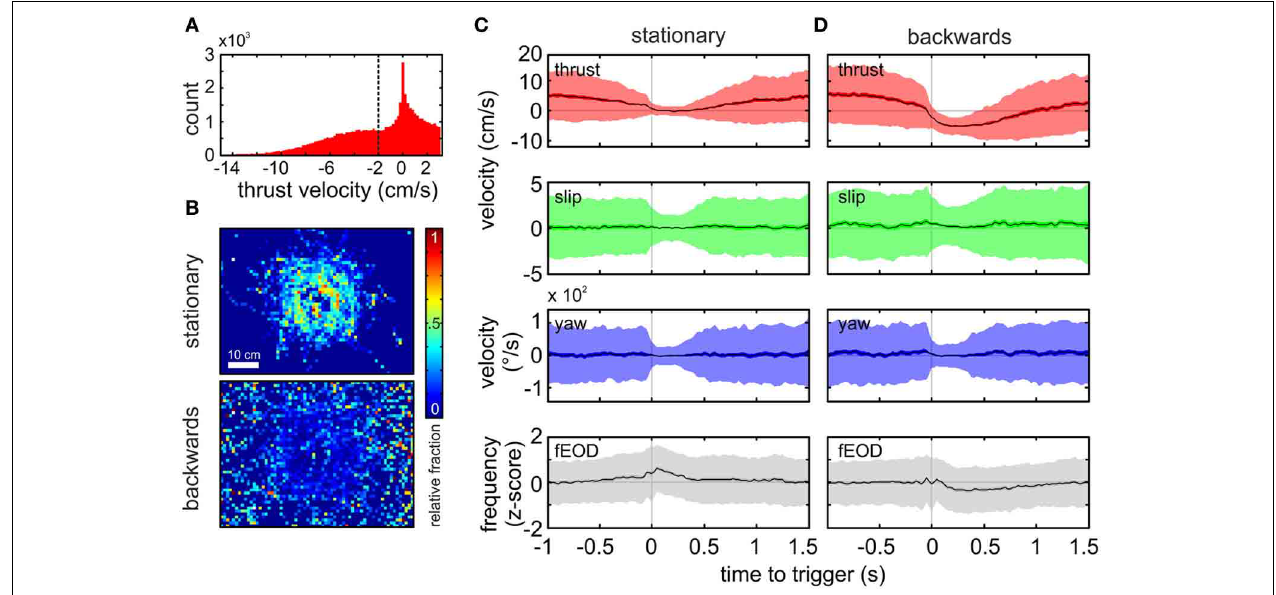
FIGURE 4 | Spatial and kinematic characterization of “stationary behavior” and “backwards swimming” patterns. (A) Histogram of the thrust velocity of all frames classified as PM 01 ( n = 50931, bandwidth = 0.2cm s − 1 ). We chose a threshold of − 2cm s − 1 to further subdivide chains of PM 01 into “stationary behavior” and “backwards swimming” chains. Homogenous chains with a minimum of 10 consecutive frames were analyzed exclusively. (B) Normalized spatial distribution of the “stationary behavior” (top, n = 6111 frames) and “backwards swimming” (bottom, n = 5252) chains. Note that stationary chains occurred more frequently at the object, while backwards swimming chains were distributed without clear peaks. (Bin size = 1cm 2 ). (C , D) Averages of kinematic velocities and fEOD triggered by the onset of the target PM chain for “stationary behavior” ( C , 672 chains, n = 6111) and “backwards swimming” ( D , 710 chains, n = 5252). From top to bottom the panels show the mean thrust velocity, the mean slip